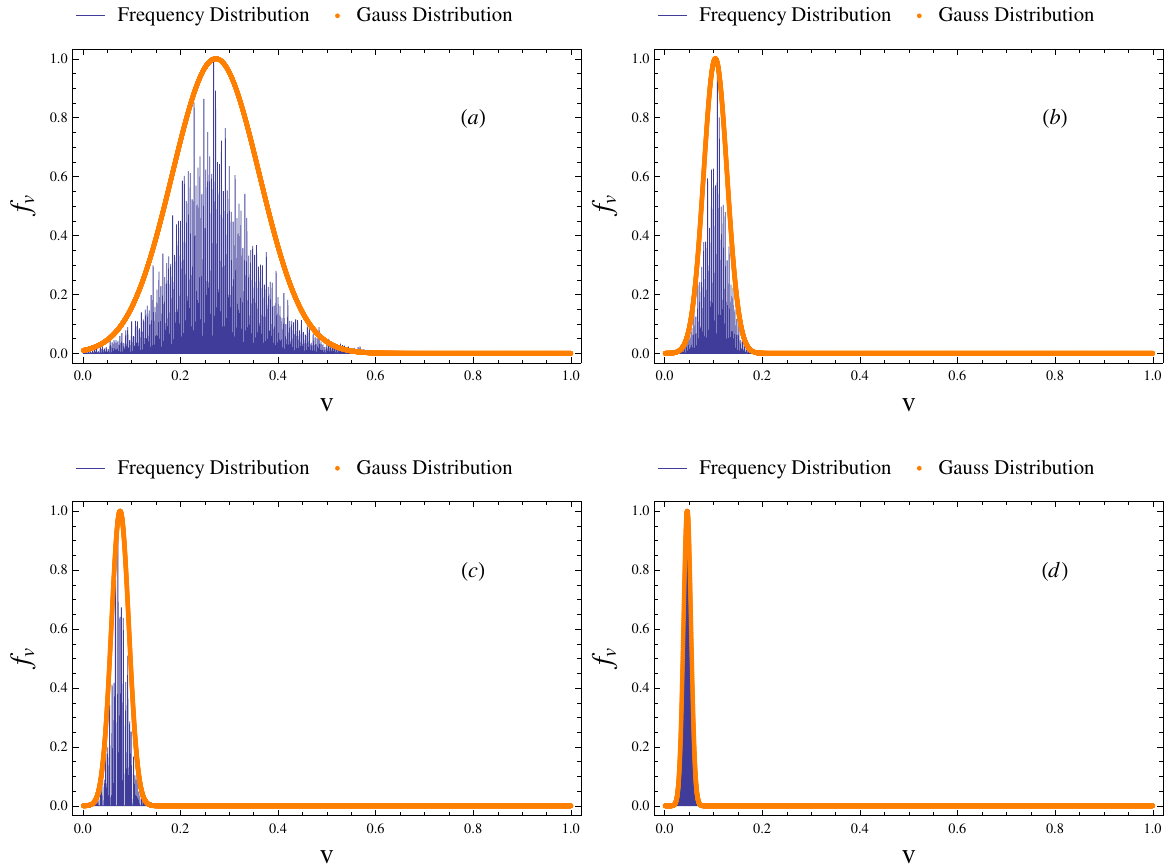
Figure 12. Comparison between the observed frequency distribution and the Gaussian probability density